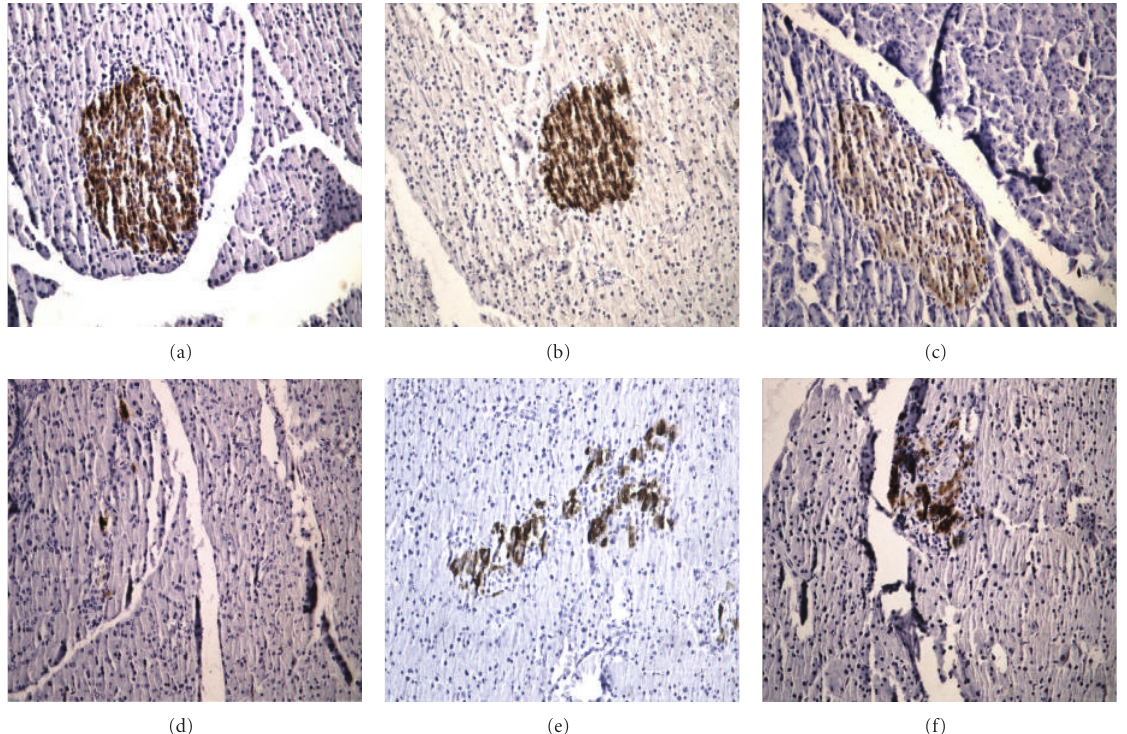
Figure 6: Immunodetection of insulin by the ABC-DAB technique in NF (a, d), IF (b, e), and CR (c, f) control (a, b, c) and STZ (d, e, f) rats.